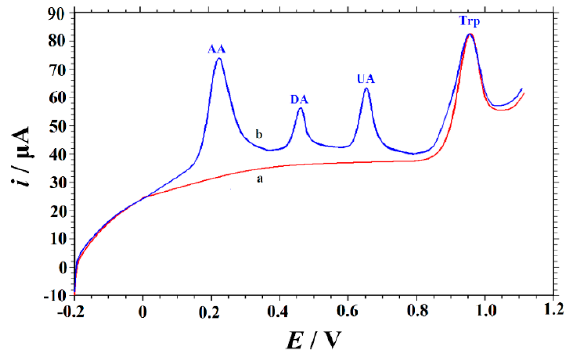
Figure 8. Linear sweep voltammograms of 10 μ M Trp in 0.05 M H 2 SO 4 solution on the Cu 2 O ‒ ERGO/GCE in the absence of (curve a) and presence of 1.0 mM AA, 10 μ M dopamine (DA), and 10 μ M uric acid (UA) (curve b). Accumulation potential: ‒ 0.1 V, accumulation time: 120 s, scan rate: 100 mV s − 1 .